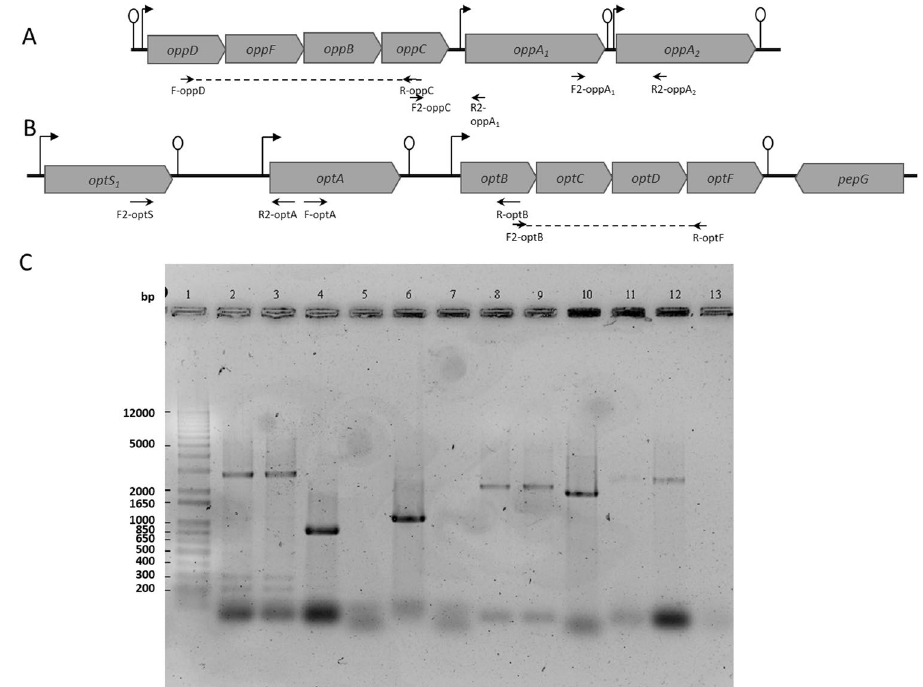
Figure 1. Genetic organization of genes encoding the oligopeptide transport systems (Opp and Opt) of L . delbrueckii subsp. lactis CRL 581. Schematic representation of the genetic organization of ( A ) opp genes and ( B ) opt genes. ( C ) RT-PCR analysis of the transcriptional organization of opp and opt operon. Broken arrows and lollipops represent the putative promoters and terminators, respectively. Dotted lines indicate the expected size of the PCR fragments. Couples of horizontal arrows represent couples of primers used for the PCR reactions, F-oppD/R-oppC (lanes 2 and 3), F2-oppC/R2-oppA 1 (lanes 4 and 5), F2-oppA 1 /R2-oppA 2 (lanes 6 and 7), F2- optB/R-optF (lanes 8 and 9), F2-optS/R2-optA (lanes 10 and 11) and R-optA/R-optB (lanes 12 and 13). Lane 1, molecular weight marker (1 kb Plus DNA Ladder, Thermo Fisher Scientific); lanes 2, 4, 6, 8, 10 and 12, positive genomic DNA controls; and lanes 3, 5, 7, 9, 11 and 13, PCR amplification products obtained from the cDNA generated by the RT